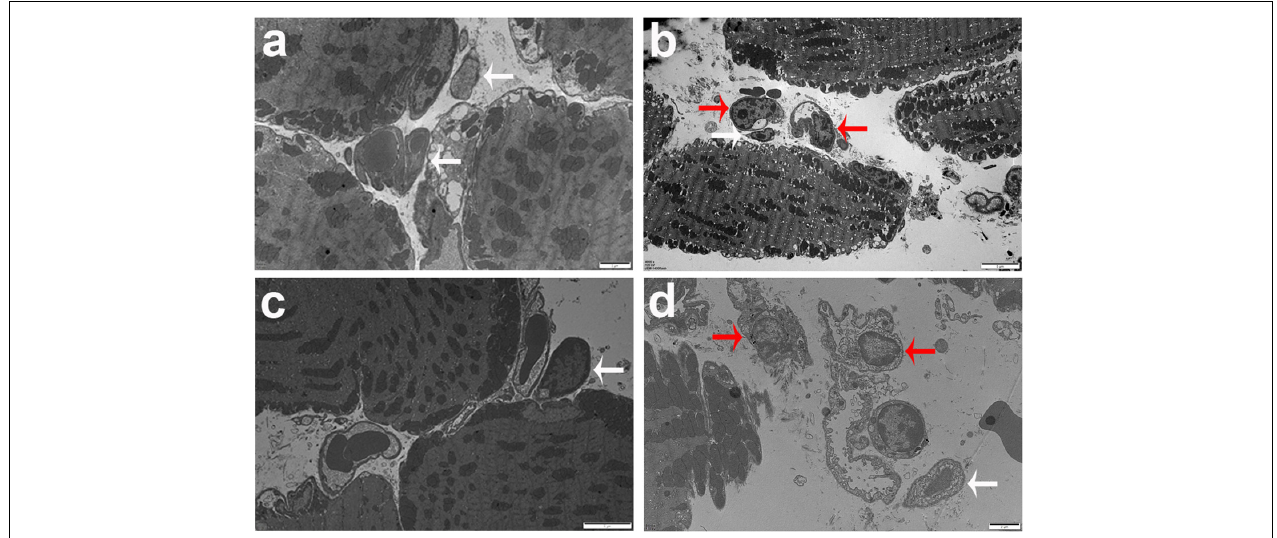
FIGURE 2 | Ultrastructural analysis of eye tissues after T. gondii infection. The images of transmission electron microscopy showed T. gondii in the eyes of B6 mouse (a,b) and BALB/c mouse (c,d) . Tachyzoites were indicated by white arrows and neutrophils were indicated by red arrows. Scale bar: a and d were 2 µ m; b and c were 5 µ m.